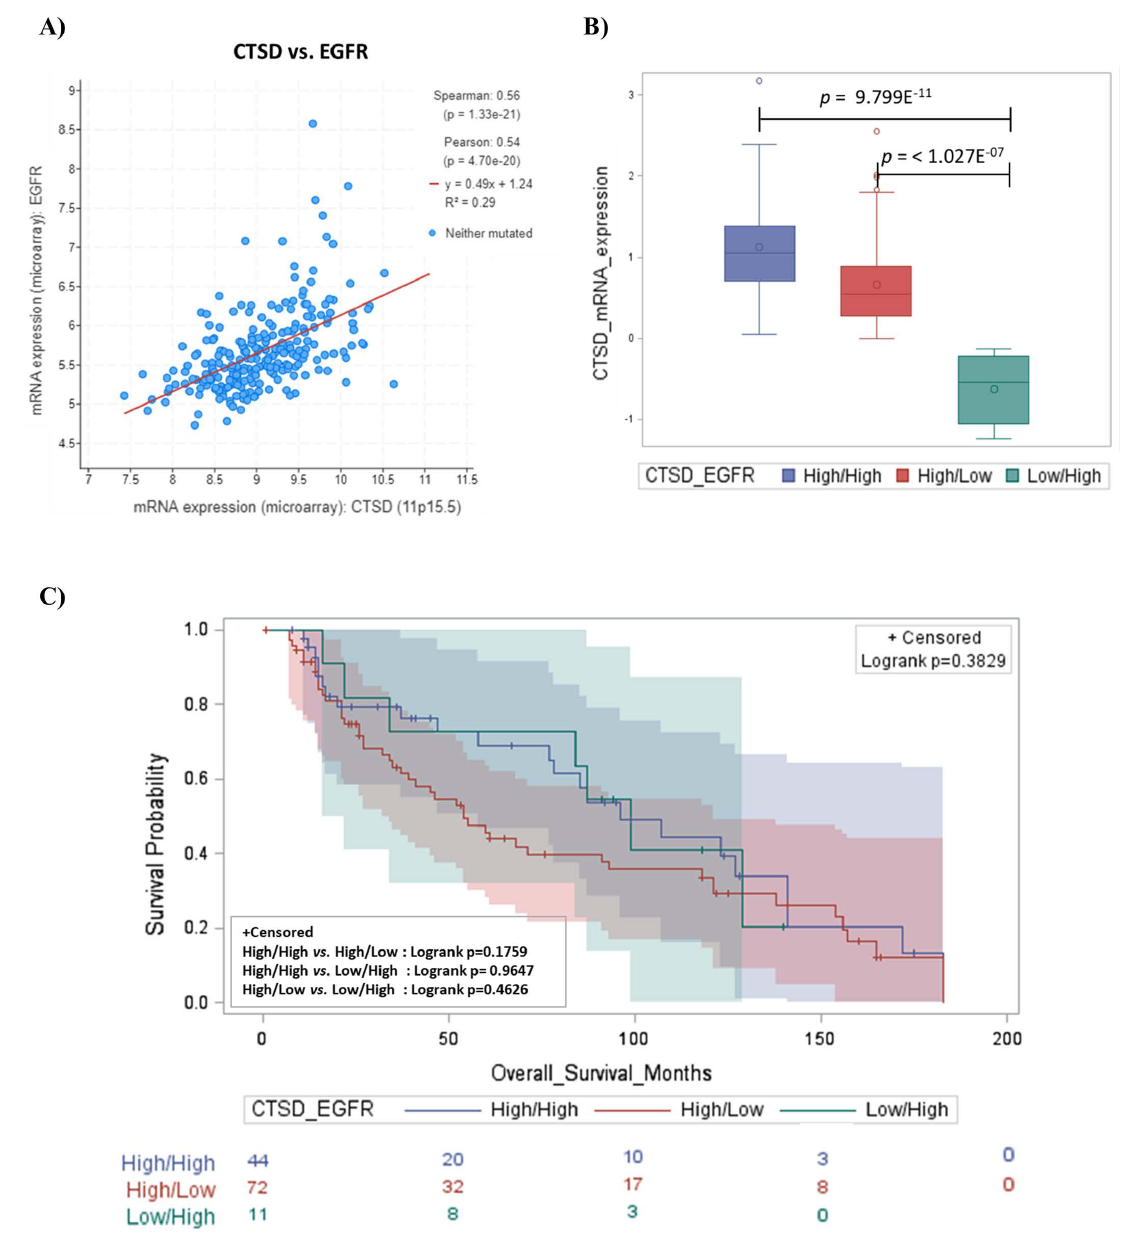
Figure 2. CTSD positively correlates with EGFR expression and patients exhibit a better prognosis. ( A ) Scatter plot showing the positive correlation between CTSD and EGFR expression. ( B ) Box- plot representing the distribution of CTSD mRNA expression level in different combinations of CTSD and EGFR —high/high, high/low and low/high groups, respectively. ( C ) Kaplan–Meier plot representing the overall survival of neuroblastoma patients according to combination of CTSD and EGFR —high/high, high/low, and low/high groups, respectively. Log-rank p value for each combination is reported in the